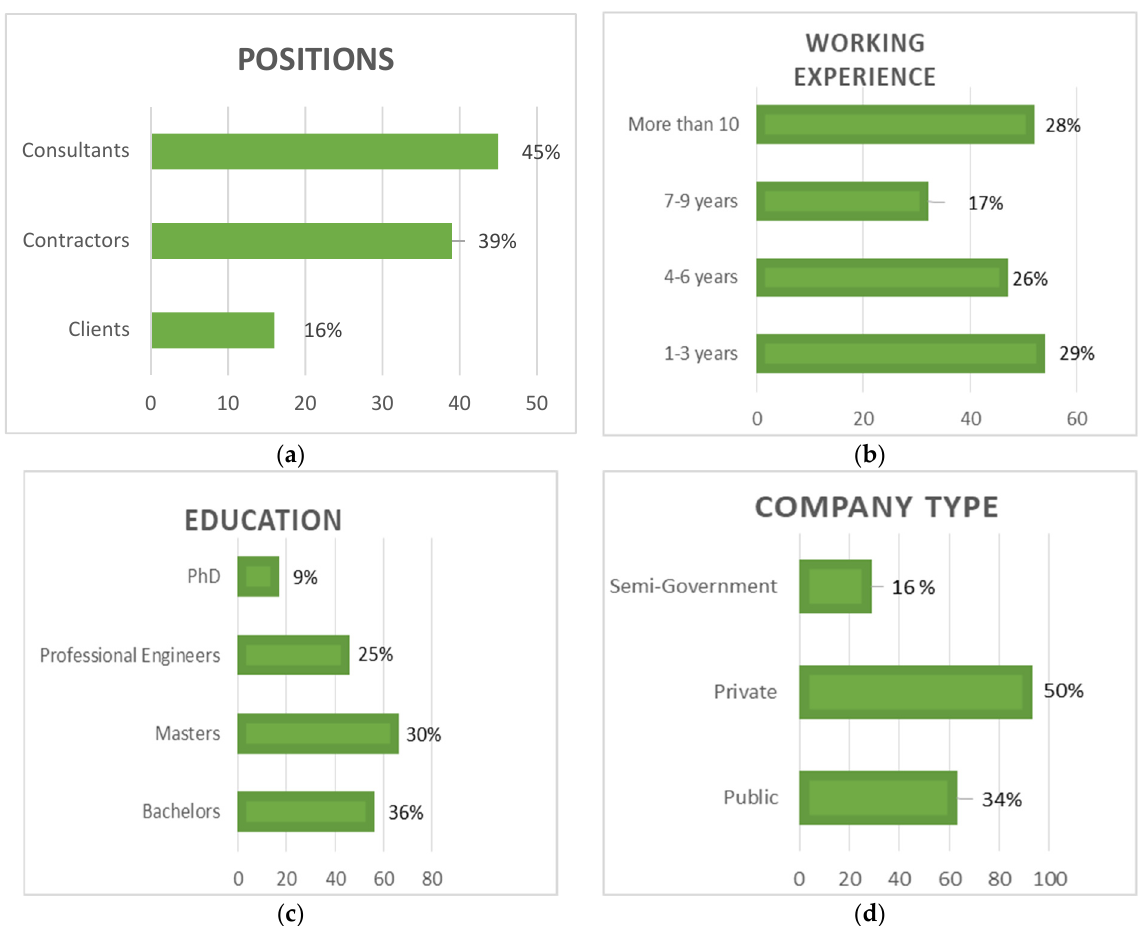
Figure 2. Breakdown of 185 returned questionnaires by Positions, Working Experience, Education, and Company Type ( a – d ).